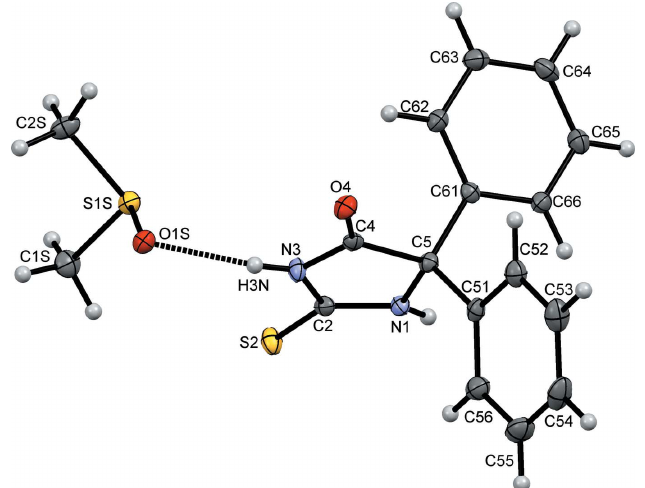
Figure 1 The asymmetric unit, showing 50% probability displacement ellipsoids.